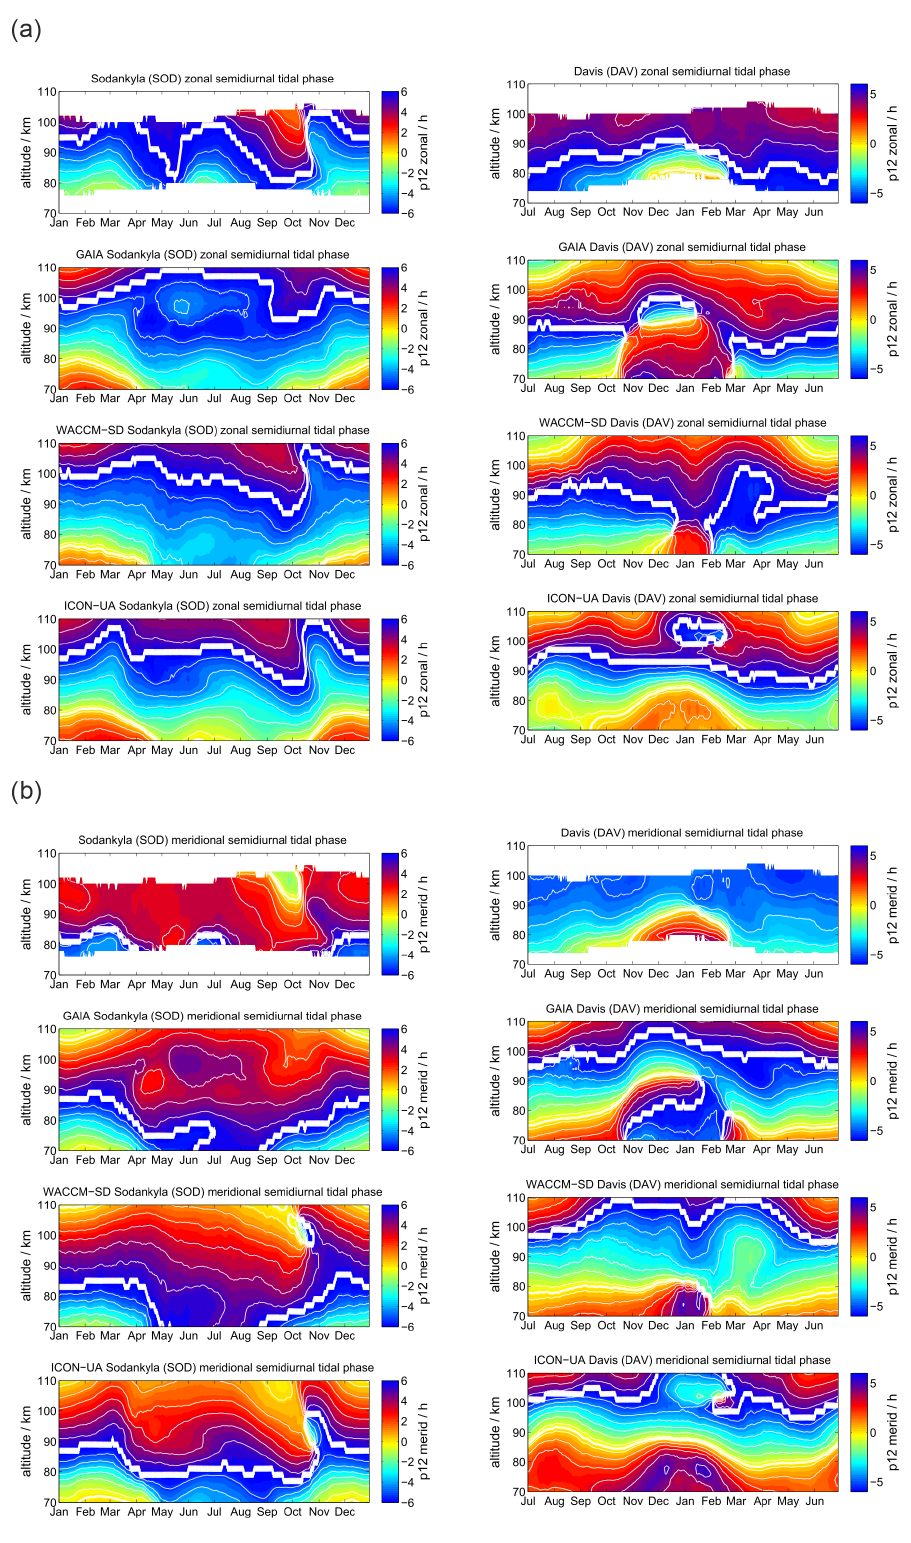
Figure 7. The same as Fig. 2, but for the semidiurnal tidal